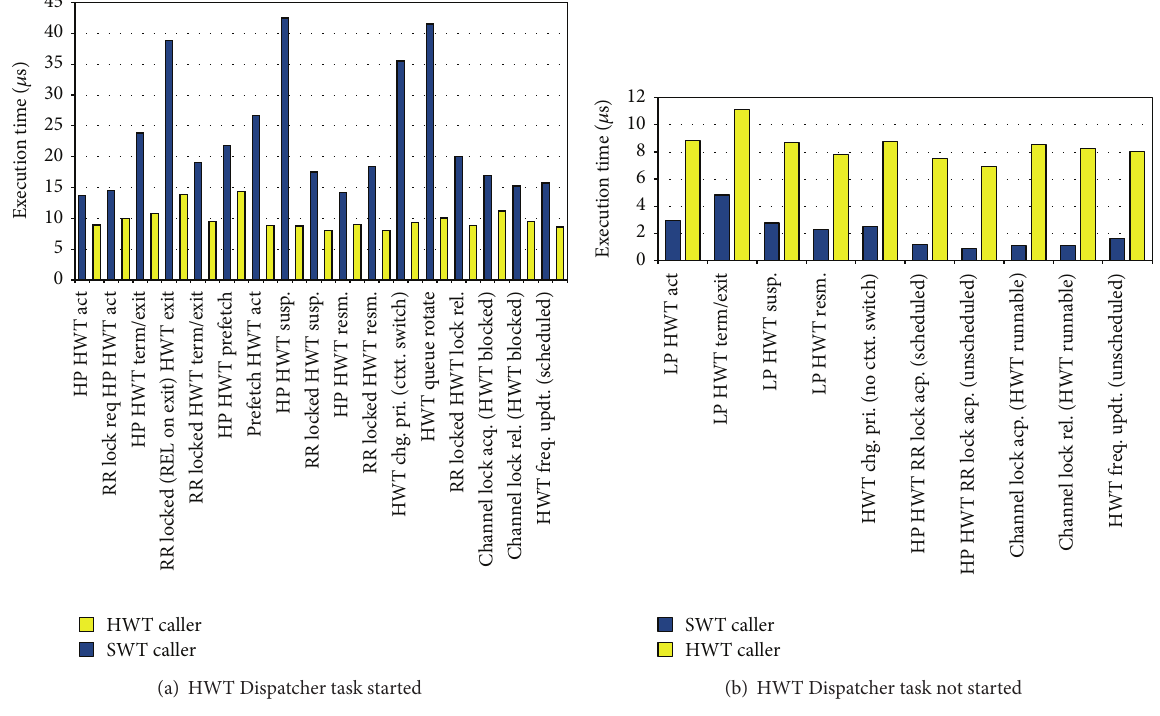
tasks in both systems run at 100 MHz. One of the base OS kernels used by ReconOS is eCoS RTOS [10] which similarly to our work is a lightweight RTOS providing only basic OS services. This makes the comparison more feasible than